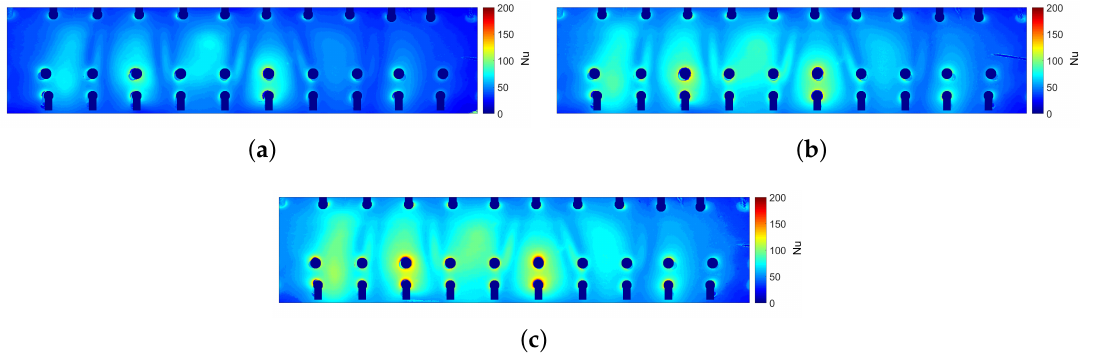
Figure 9. Comparison of measured Nusselt number distributions for geometry 4 with Re = 13,000, 17,500 and 22,000. ( a ) Re = 13,000; ( b ) Re = 17,500; ( c ) Re = 22,000.